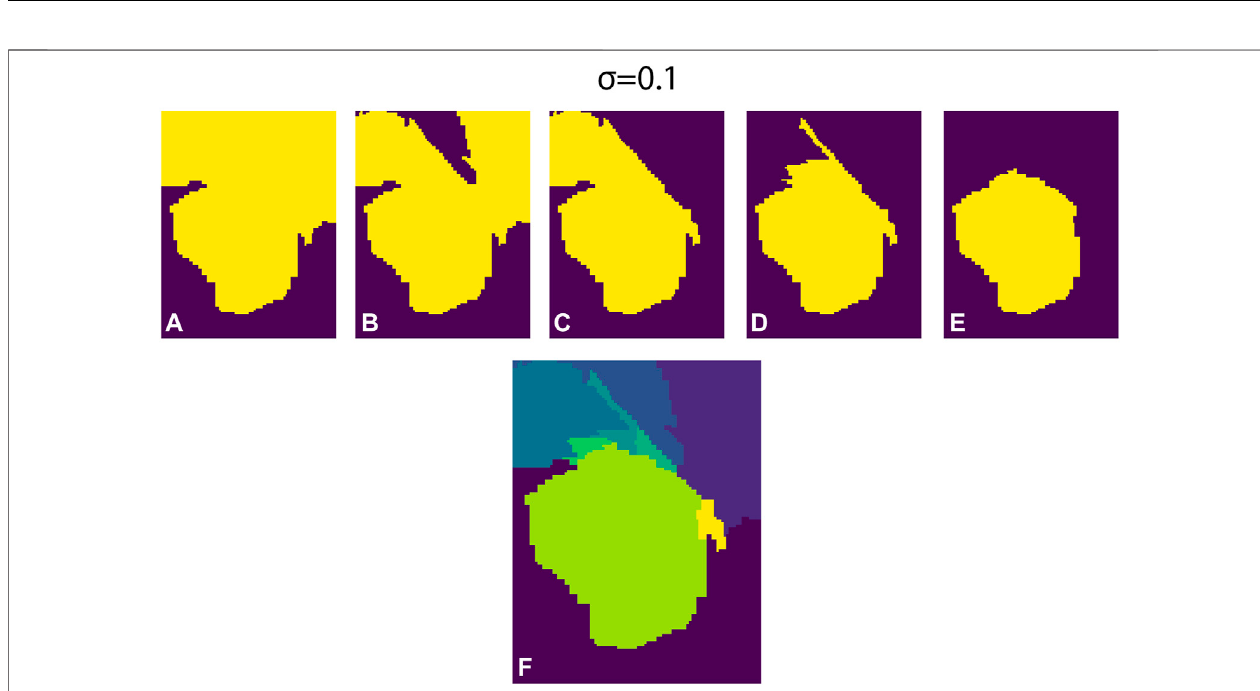
Frontiers in Signal Processing |